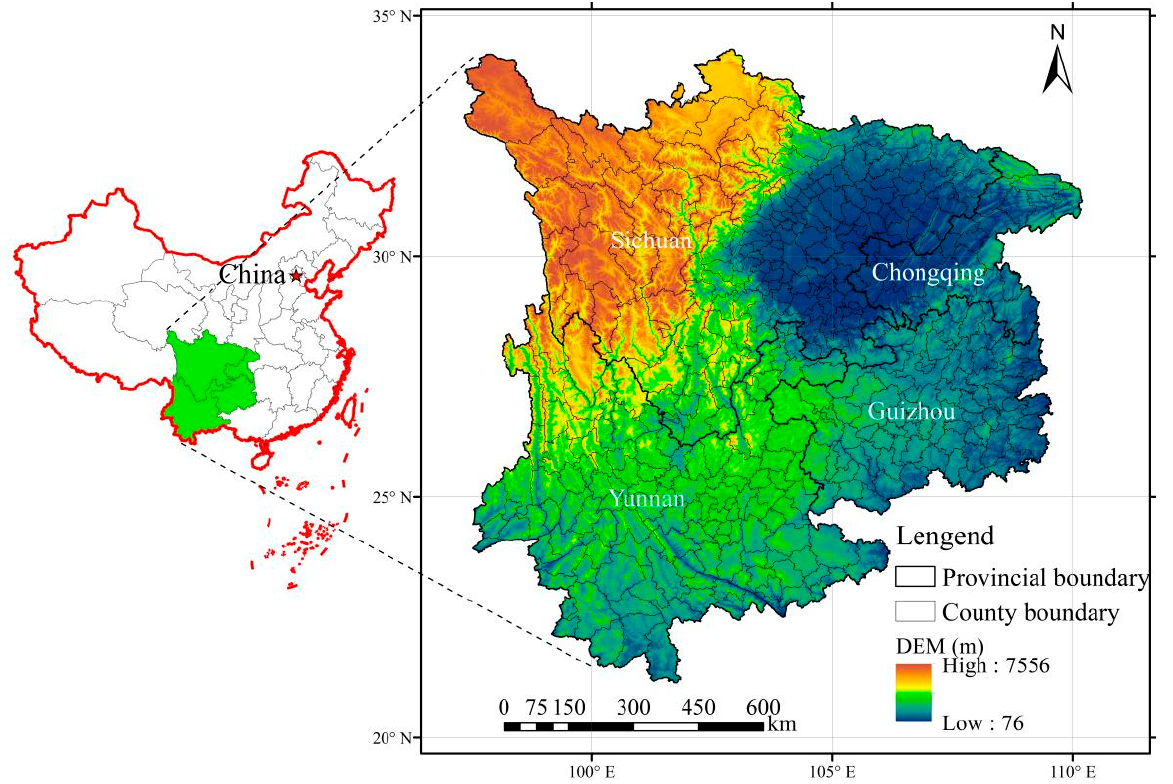
Figure 2. Location of the mountainous areas of southwest China. The main map is a digital elevation model (DEM) of southwest China.